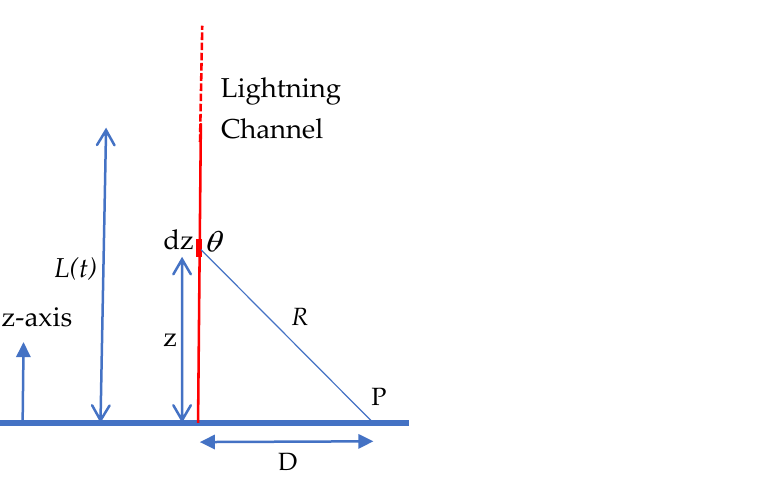
Figure 1. Geometry relevant to the calculation of the electromagnetic fields from a return stroke. In the diagram, L ( t ) is the return stroke front as seen by an observer at P.